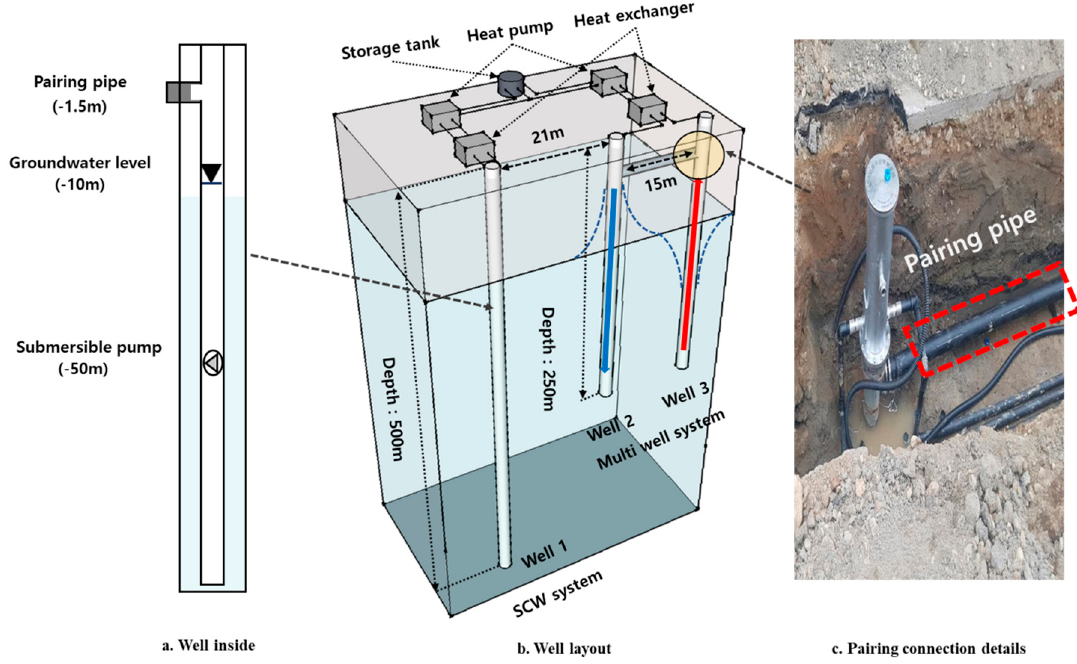
Figure 4. Overview of the experimental site.